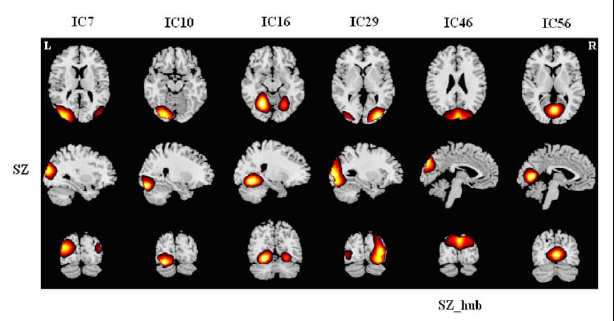
FIGUREA6 | Spatial maps of brain components in moduleVI for SZs. Hub of this module is labeled. Each column shows one component in axial, sagittal, and coronal views.This module was designated as “occipital module” (O Module) because all the components are centered over occipital cortex. For HCs, occipital components were distributed across other